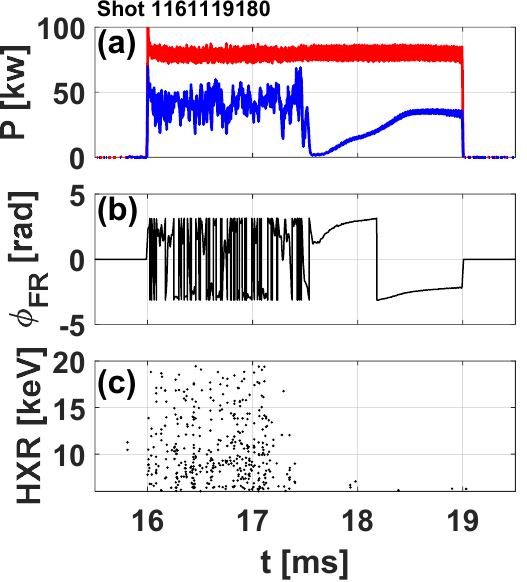
Fig 8. Characteristic changes in reflected (blue) power and phase due to arcing occurring at the ~17.5ms during an 80kW forward power (red) RF pulse. Substantial reduction in reflected power fluctuations (a) and phase (wrapped to ±π) fluctuations (b) are observed with simultaneous termination of target bremsstrahlung x-rays (c) from heated electrons.